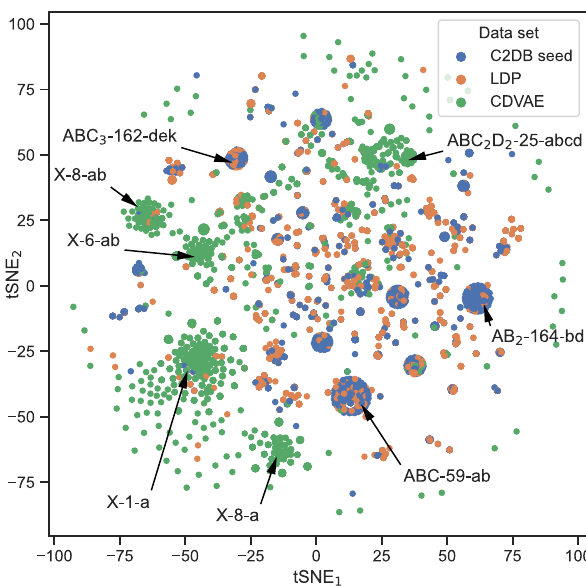
Fig. 7 t-SNE visualization of the structural diversity. t-SNE embedding of the structure represented as a individual one-hot encoding of the stoichiometry, space group, and occupied Wyckoff positions. Selected clusters are highlighted as “ stoichiometry ” - “ space group ” - “ Wyckoff position ” . “ X ” corresponds to an arbitrary